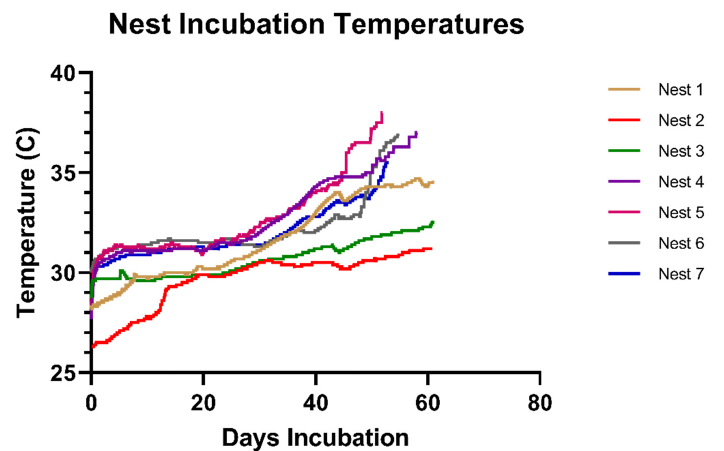
Figure 3. Time-series plot of nest temperatures recorded by temperature loggers deployed in leatherback sea turtle ( Dermochelys coriacea ) nests in March (Nest 1–3), April (Nest 4–5), May (Nest 6–7) in 2019 on Levera Beach, Grenada.